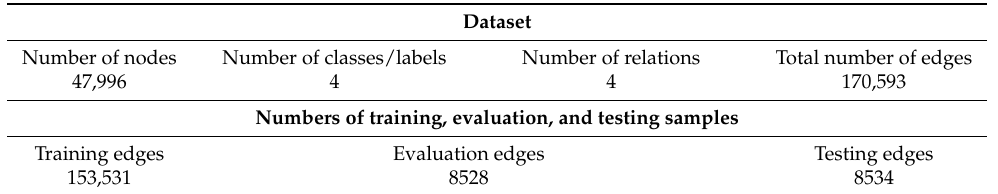
Table 2. Statistics of the dataset produced by the Dataset